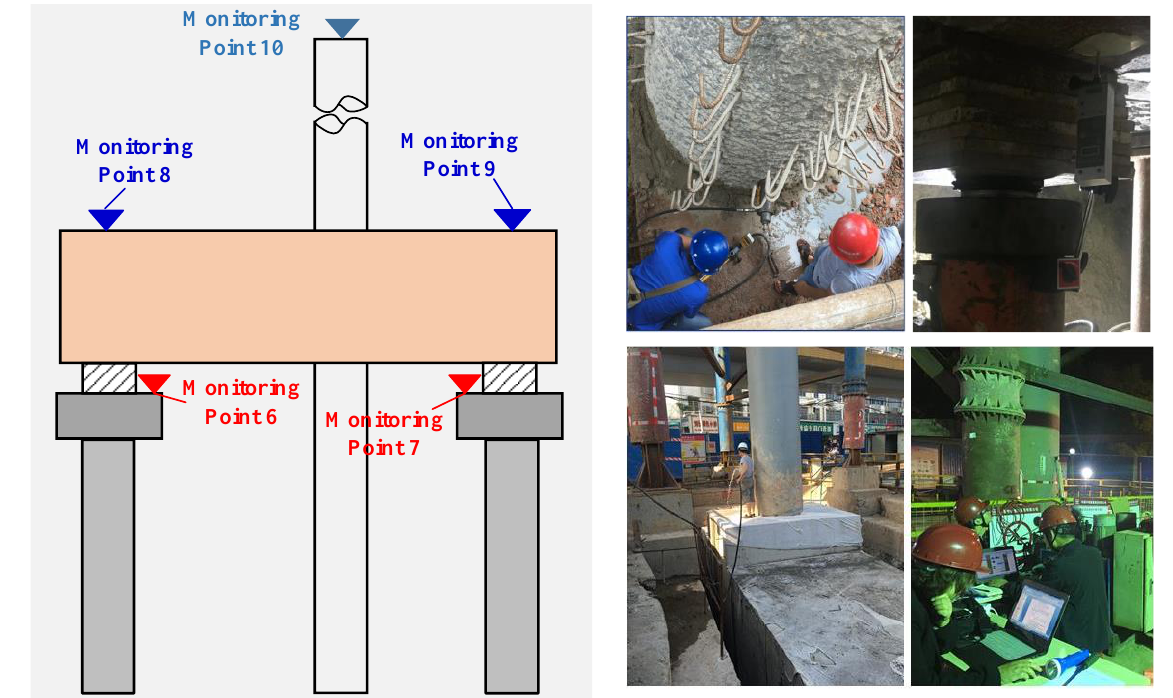
Figure 10. Layout of the monitoring points during underpinning construction ( left ) and the field monitoring ( right ).